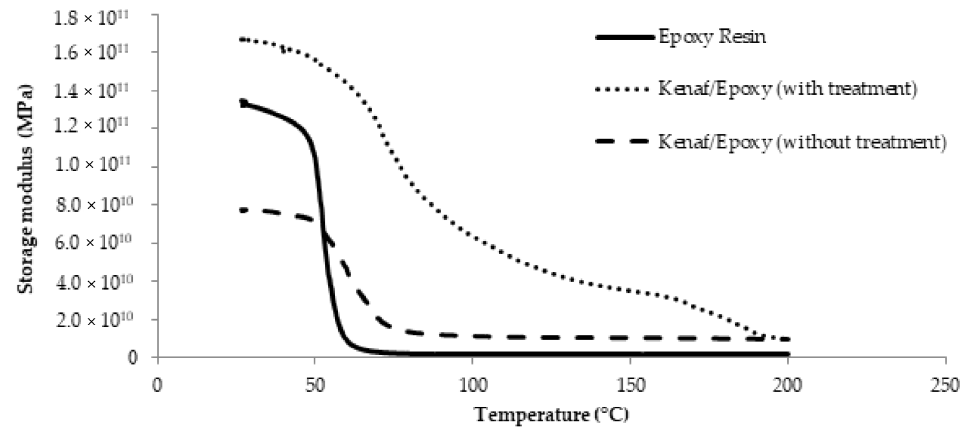
Figure 10. Storage modulus, E ′ spectra for epoxy composite reinforced with untreated and treated kenaf fiber.